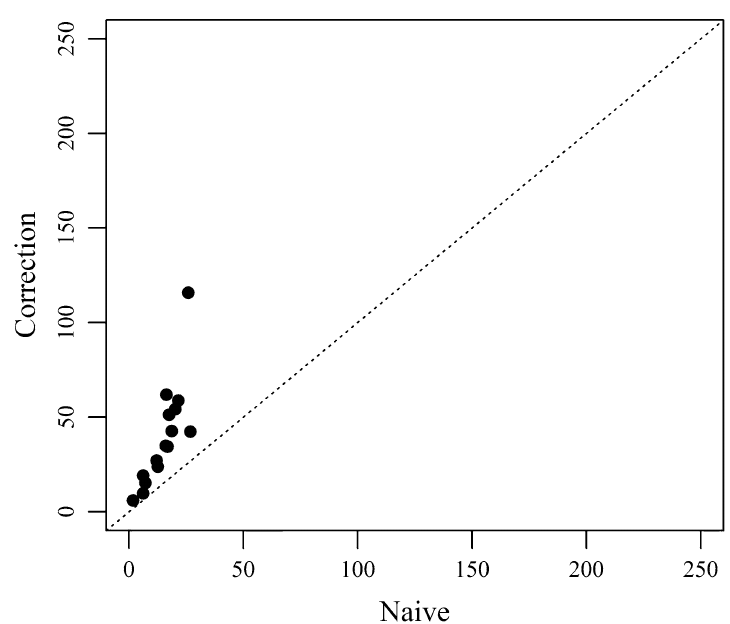
Fig. 4 HIV/AIDS knowledge naive and correction model parameters for the SES index. Note. Parameter estimates are the posterior